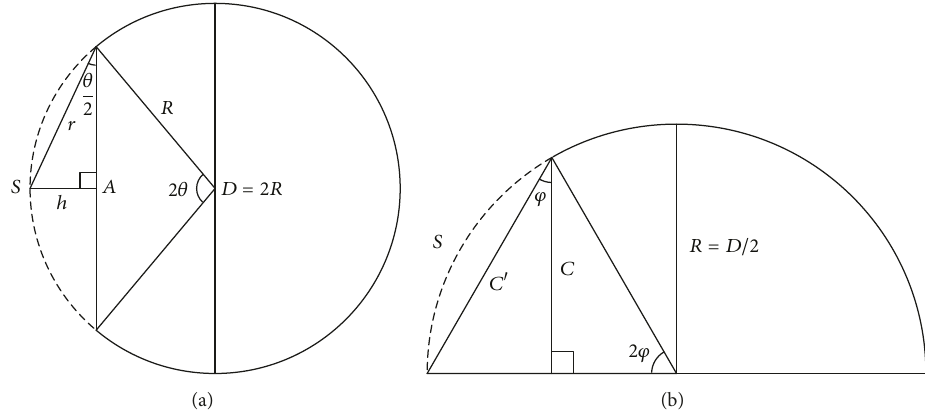
Figure 5: Schematic of the skull defect. (a) The skull is modeled as a spherical dome with the diameter D = 2R. The base diameter of the skull defect ( S , dashed) is 𝐴 . The apex angle of the spherical cap is 2 𝜃 . (b) Coronal view of the skull dome. The defect starts from the skull base, and the apex angle is 2 𝜑 . Although the height is C , the actual base diameter is 𝐶 󸀠